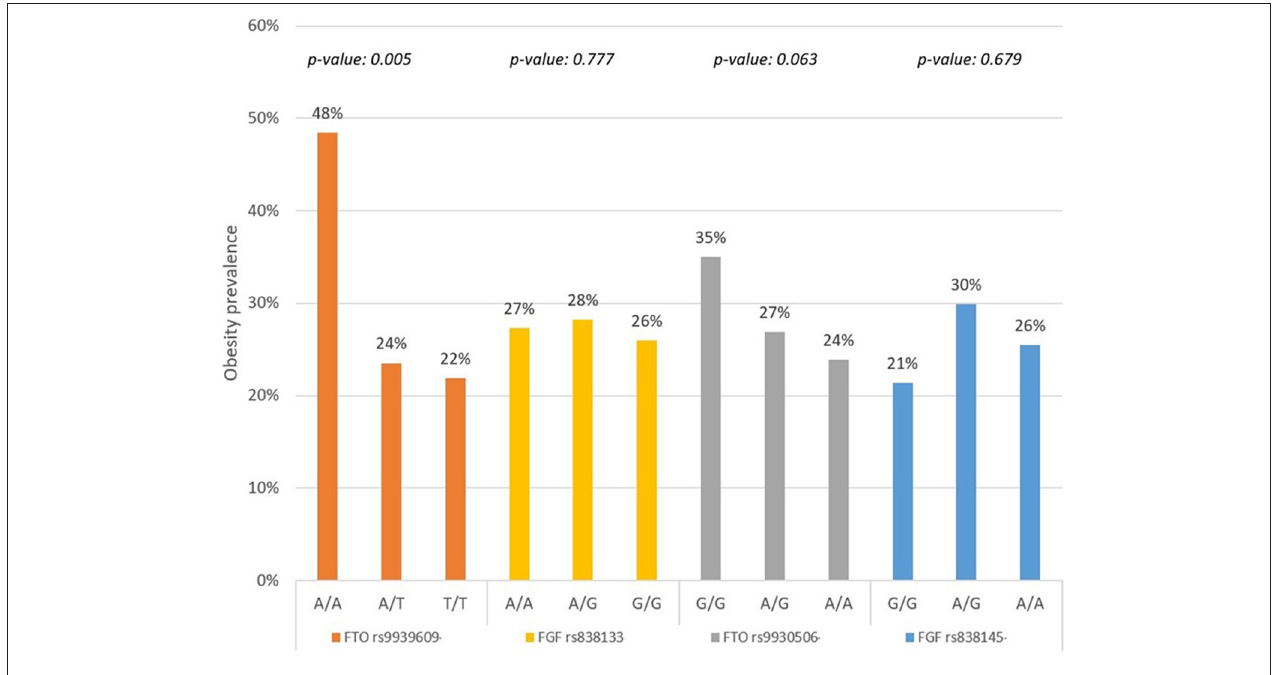
FIGURE 1 | Prevalence of obesity by gene and risk allele in the study population ( n = 194).